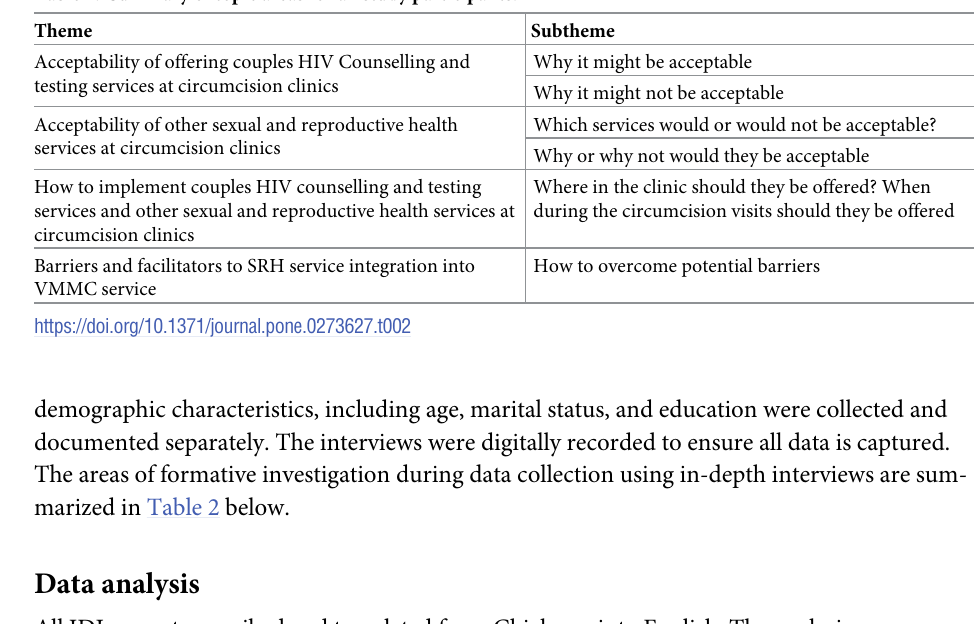
Table 2. Summary of topic areas for all study